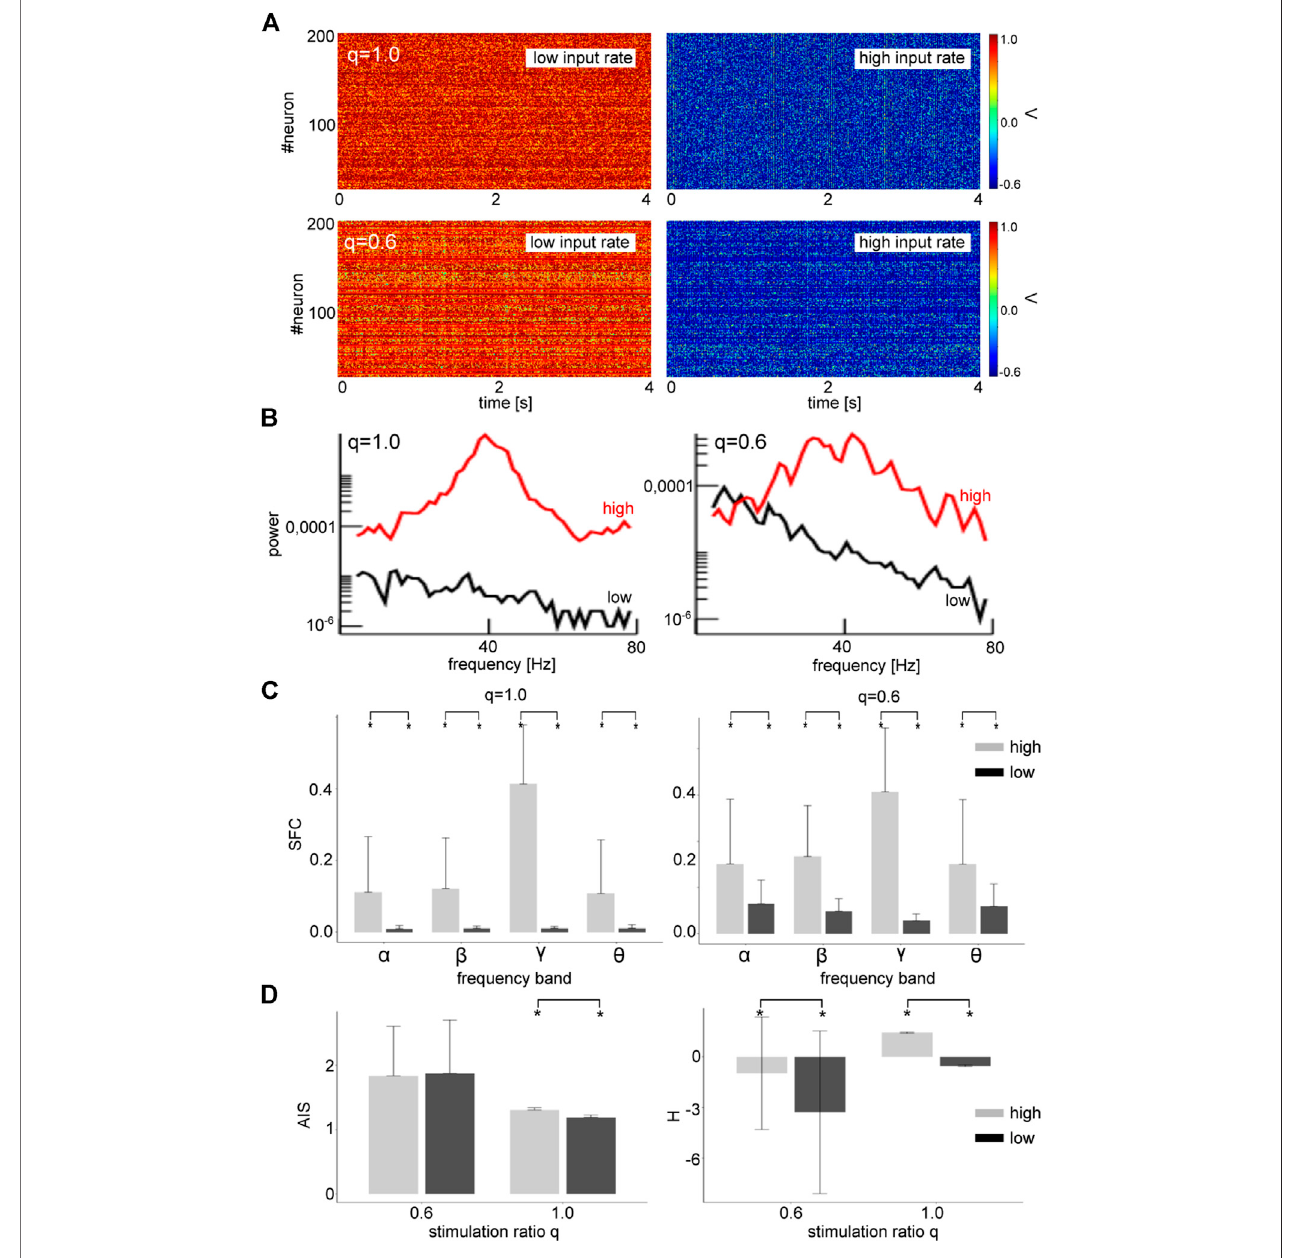
FIGURE11| Poissonnoiseinducestransitionsfrom anon-oscillatorytoanoscillatory stateforbothglobaland partialstimulation. (A) Network activity V n ( t ) forlow input fi ringrate( r (cid:1) 0 . 04for q (cid:1) 1 . 0and r (cid:1) 0 . 09for q (cid:1) 0 . 6)andhighinput fi ringrate( r (cid:1) 0 . 14for q (cid:1) 1 . 0and r (cid:1) 0 . 19for q (cid:1) 0 . 6).Forthelow(high)inputratethesystem evolves about an upper (lower) state. (B) Power spectra of the network mean V ( t ) showing c − activity for the largeinputrate. (C) The high input fi ring rate (grey-colored) inducesastateoflargeSpikeFieldCoherencecomparedtothestateforlowinput fi ringrate(black-colored)forbothglobalandpartialstimulation( p < 0 . 01). (D) For globalstimulation ( q (cid:1) 1 . 0),highinput fi ringinduces astateofsigni fi cantlyenhanced storedactive information( AIS )and availableinformation( H ).Thisisnotconsistentto results for partial stimulation ( q (cid:1) 0 . 6 ) . Here is p < 0 . 01.